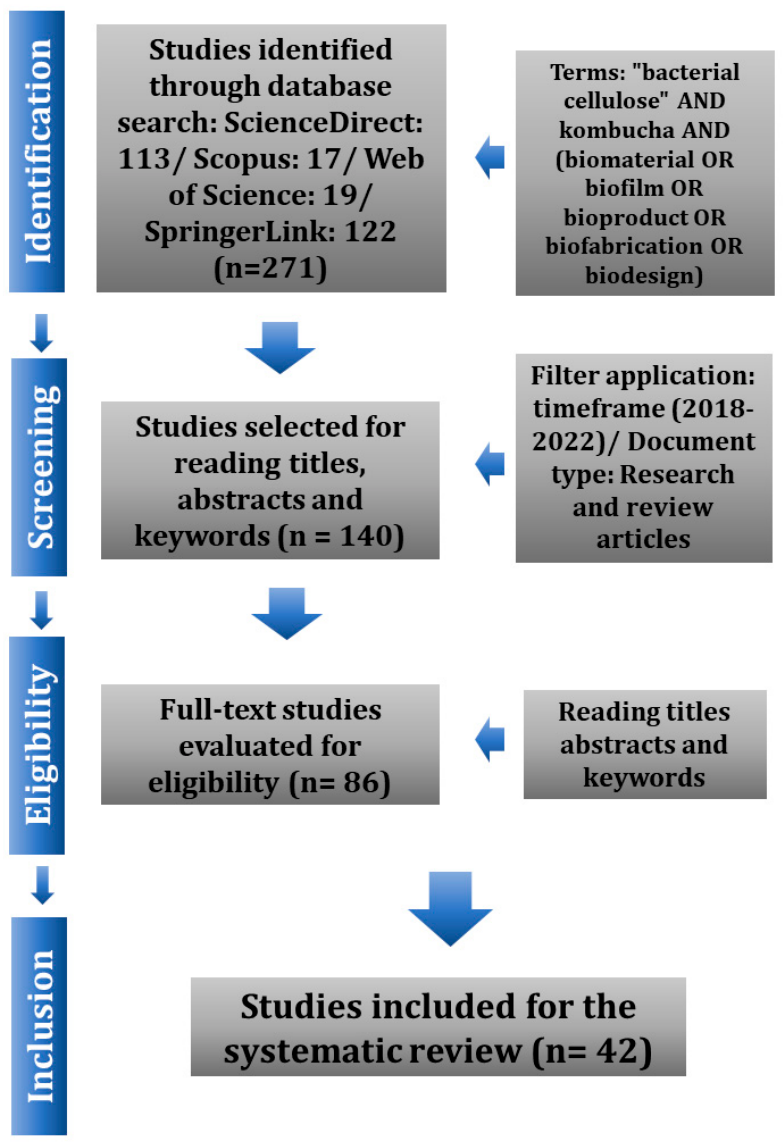
Figure 1. Exemplification of the method used for the selection of research articles. Source: authors, 2022.